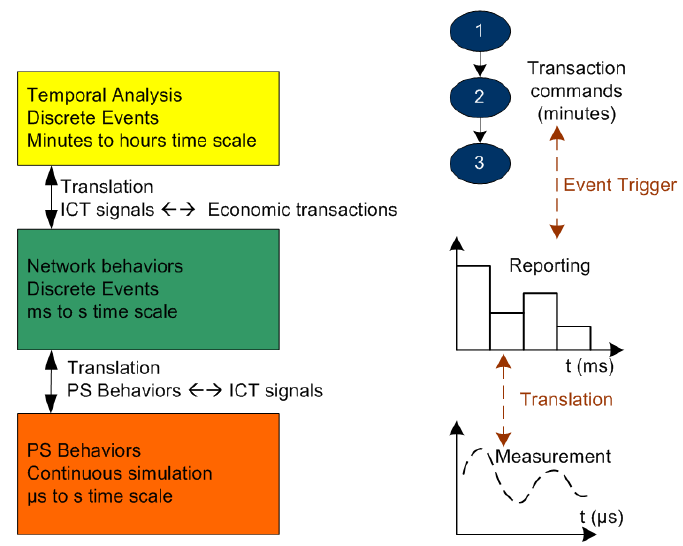
Figure 3. Illustration of syntactic layer of a CPES co-simulation